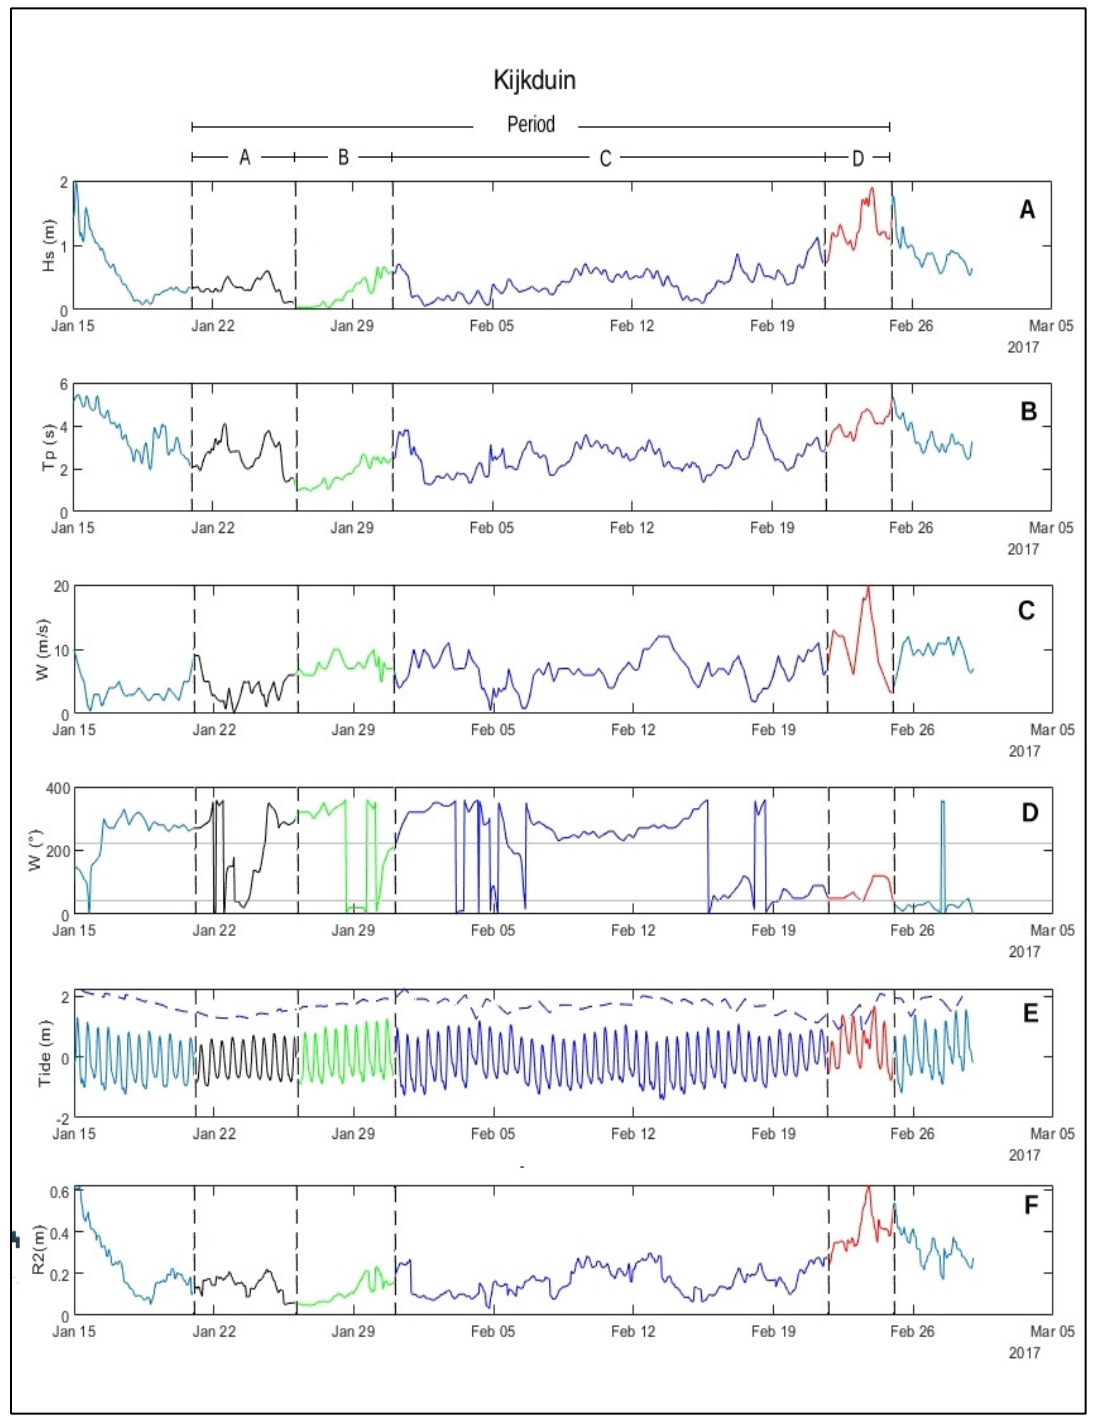
Figure 6 . ( A ) Significant wave heights; ( B ) peak wave periods; ( C ) wind speeds; ( D ) wind directions; ( E ) tidal water levels,(solid line) and range (dashed line); ( F ) run-up, in the period 15 January to 28 February 2017, at Kijkduin (see Figure 5 for the output location). Vertical dashed lines indicate the periods (A–D) which are analyzed in more detail in Section 3. Horizontal lines in subplot (D) indicate the orientation of the coast at Kijkduin. Wind directions between 40° and 220° are offshore directed and other wind directions are onshore directed.